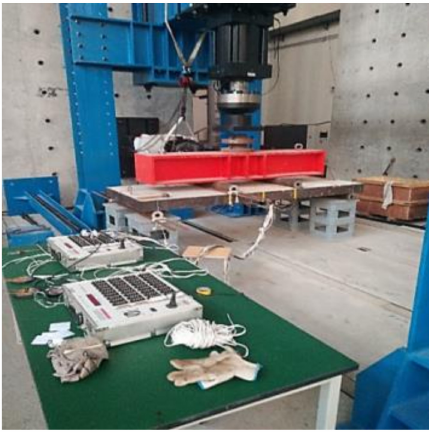
Figure 8. Loading of composite floor.